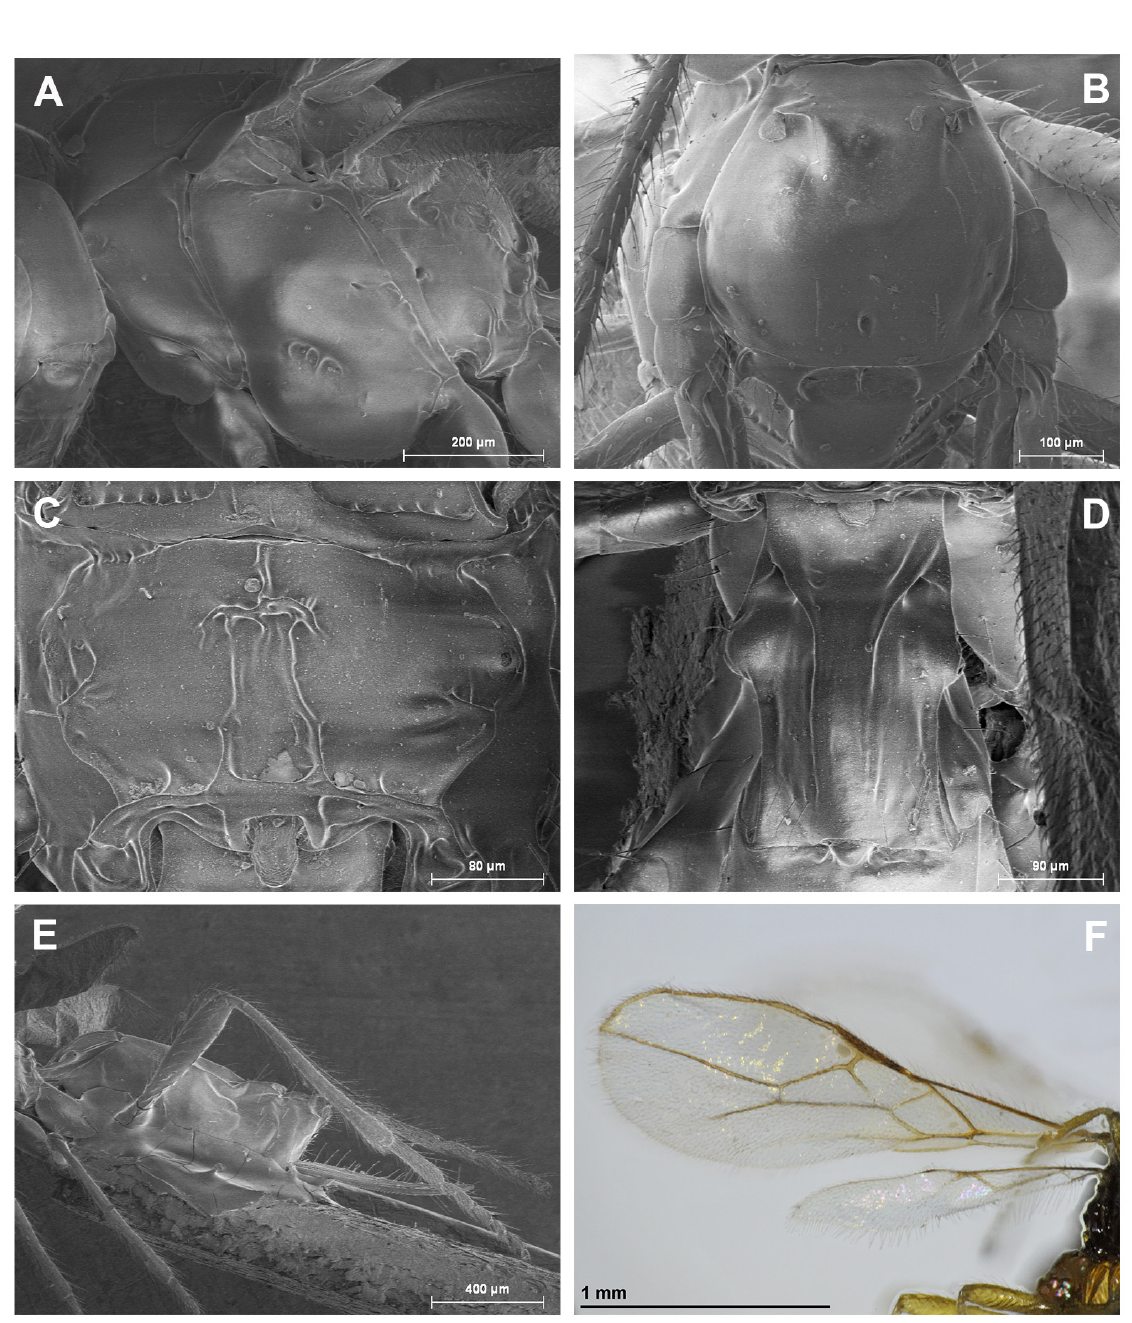
Fig. 20. Asobara ghesquierei (Fischer, 1963), ♀, holotype (MRAC). A . Mesosoma, lateral view. B . Mesoscutum, dorsal view. C . Propodeum. D . First metasomal tergite, dorsal view. E . Hind leg, metasoma and ovipositor, lateral view. F . Fore and hind